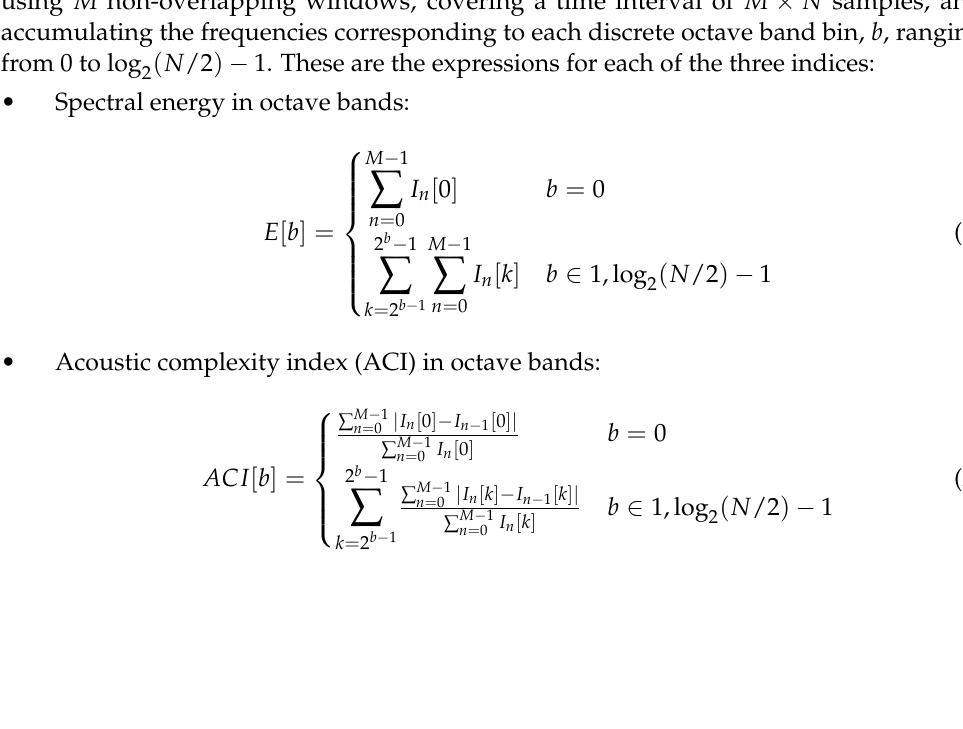
Figure 4. MASE Internal system tray. Figure 4. MASE internal system